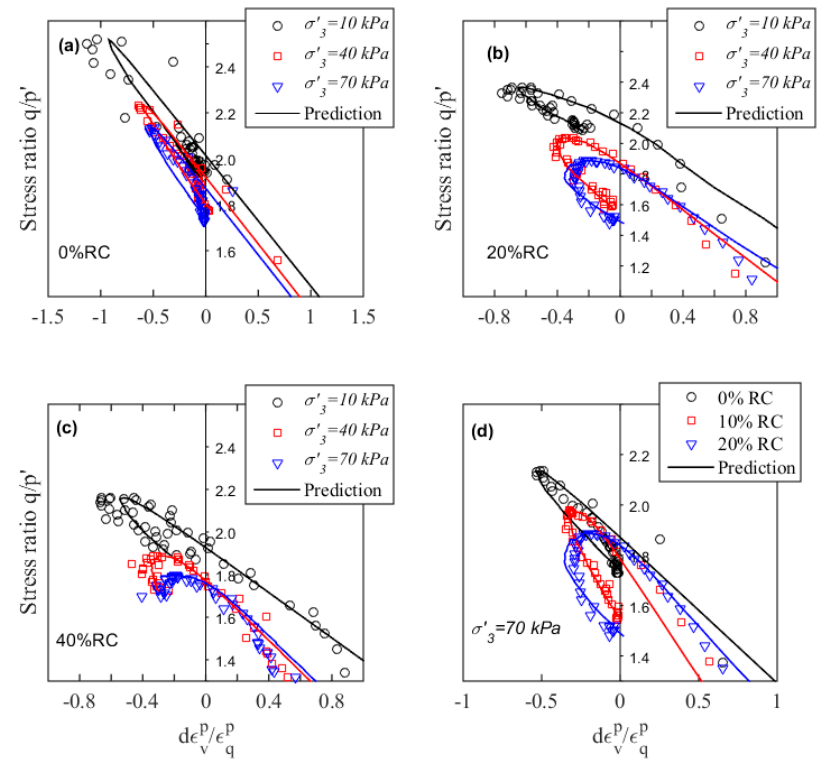
Figure 7. Dilatancy model predictions and the test results for SFS+CW+RC mixtures ( a ) having 0% RC under different effective confining pressures, ( b ) having 20% RC under different effective confining pressures, ( c ) having 40% RC under different effective confining pressures, and ( d ) having different RC contents under 𝜎′ (cid:2871) = 70 kPa .